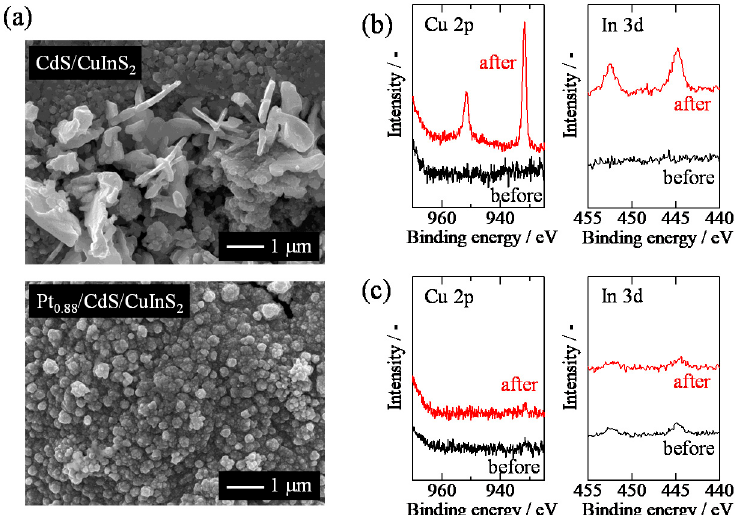
Figure 8. ( a ) SEM images of CdS/CuInS 2 (upper) and Pt 0.88 /CdS/CuInS 2 (lower) photoelectrodes after 120 min of photoelectrolysis. (The SEM images of CdS / CuInS 2 and Pt 0.88 / CdS / CuInS 2 photoelectrodes 120 min of photoelectrolysis. (The SEM images of CdS/CuInS 2 and Pt 0.88 /CdS/CuInS 2 photoelectrodes before the photoelectrolysis are shown in Figure 3a,e, respectively.) Comparison of XPS spectra of ( b ) ( b ) CdS / CuInS 2 and ( c ) Pt 0.88 / CdS / CuInS 2 electrodes before and after 120 min of CdS/CuInS 2 and ( c ) Pt 0.88 /CdS/CuInS 2 electrodes before and after 120 min of photoelectrolysis.